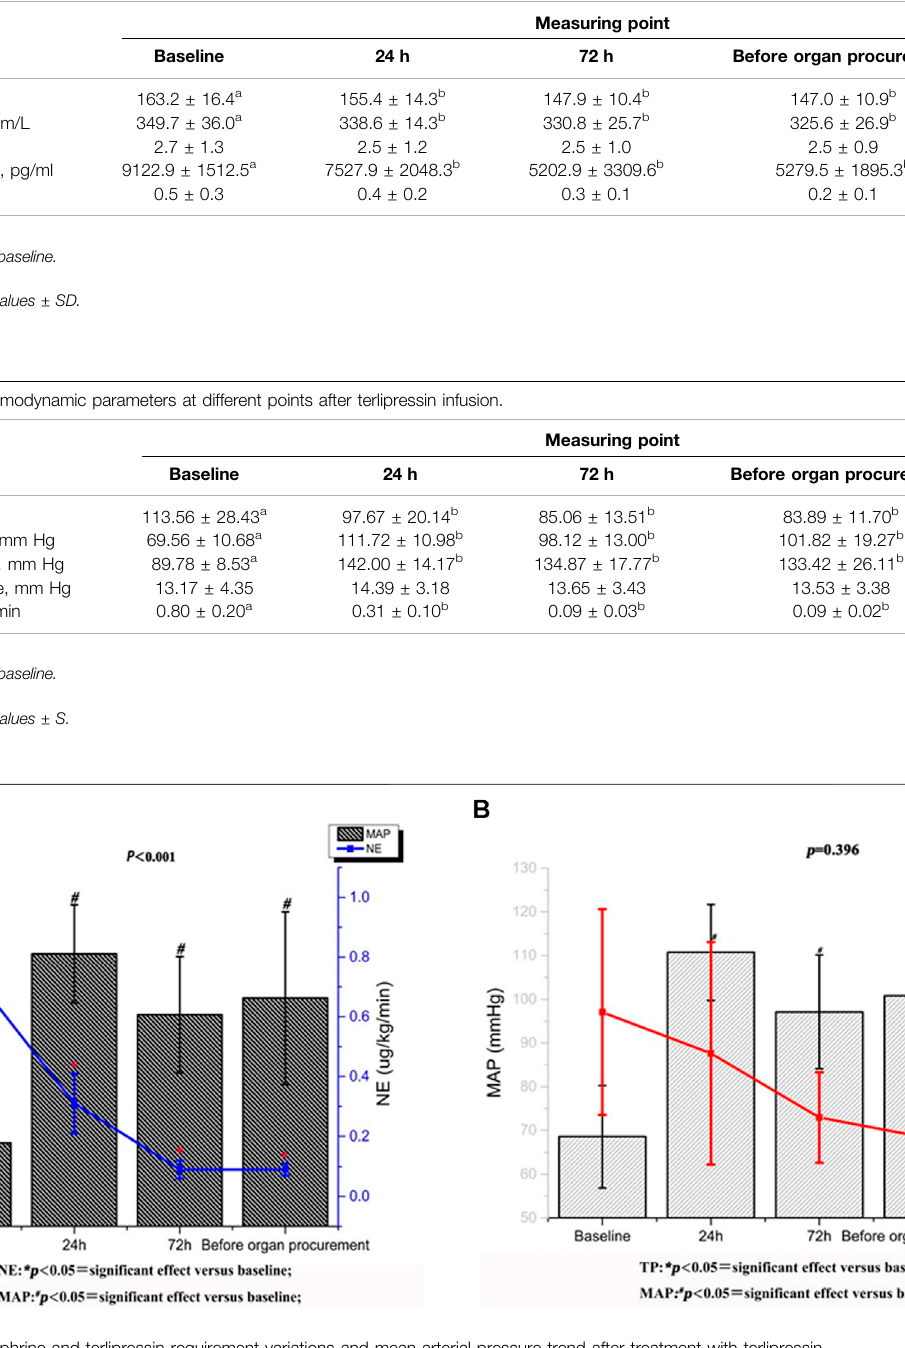
Frontiers in Pharmacology |